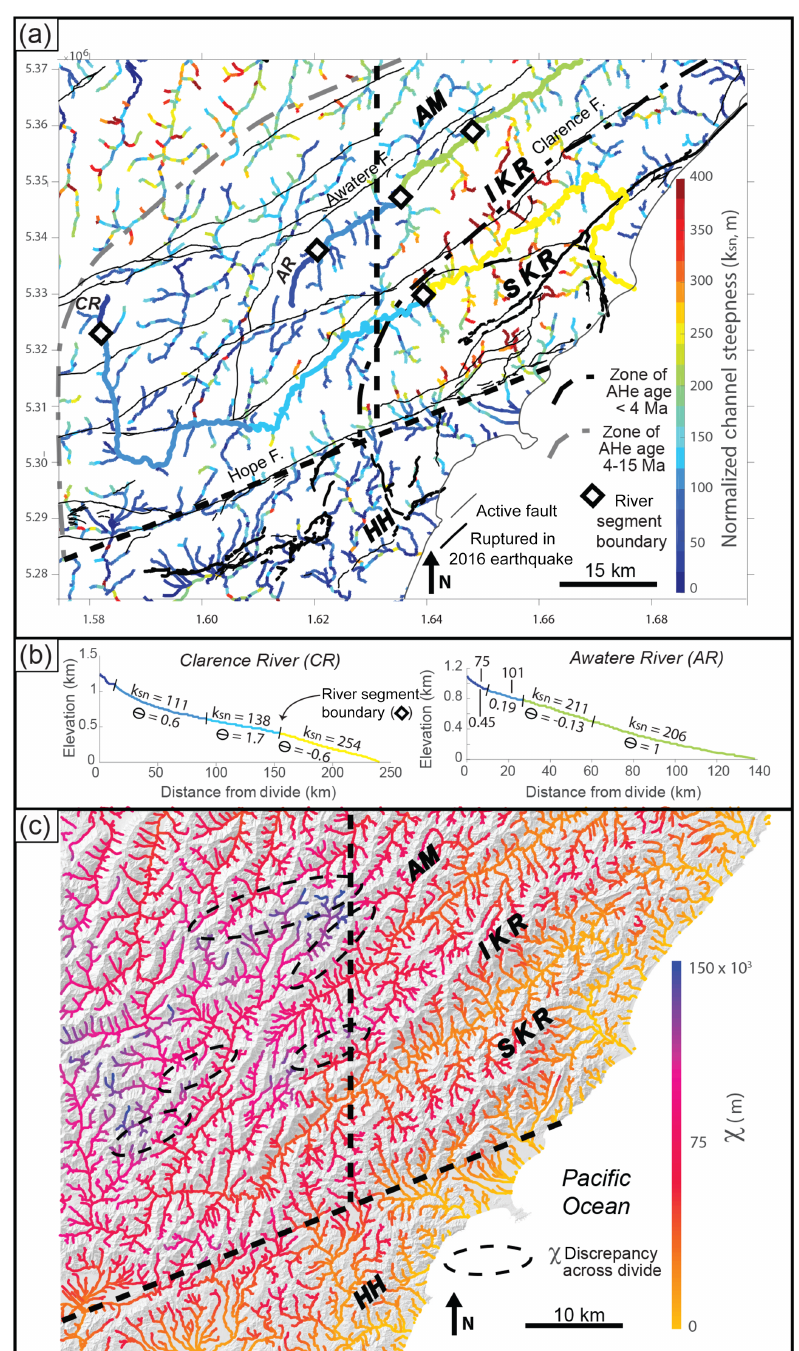
Figure 5. (a) Map of normalized channel steepness for study site channels. Map generated using the k sn batch function in the Topographic Analysis Kit (Forte and Whipple, 2019). K sn of main Awatere (AR) and Clarence (CR) river segments (heavier line weight) and segment boundaries (white diamonds) estimated from manual designation of segments on longitudinal channel profiles using the KsnProfiler function (see panel b ). Black and gray doted–dashed lines outline zones of apatite (U–Th)/He (AHe) ages from Collett et al. (2019). AM – Awatere mountains, IKR – Inland Kaik¯oura Range, SKR – Seaward Kaik¯oura Range, and HH – Hundalee Hills. Dashed black lines show topographic domain boundaries (same as in Fig. 2). (b) Longitudinal river profiles of the Clarence and Awatere main stem rivers. Colors in panel (b) reflect the scale in panel (a) . k sn – normalized channel steepness, θ – concavity. (c) Map of χ for study site channels generated using the Topographic Analysis Kit (Forte and Whipple, 2019). Dashed black ovals show location of χ discrepancies across